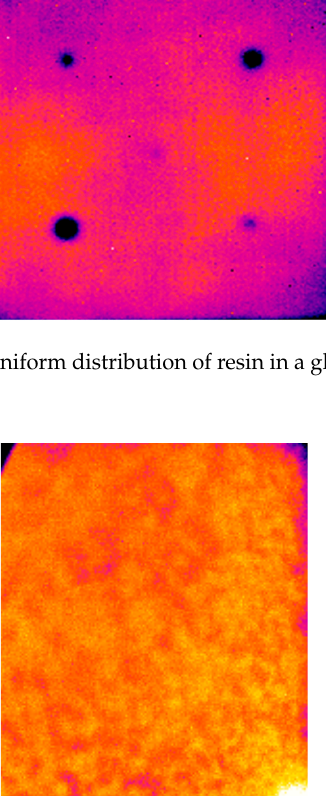
Figure 9. Distribution of carbon nanotubes in epoxy resin; phase image taken with SC3000 camera.